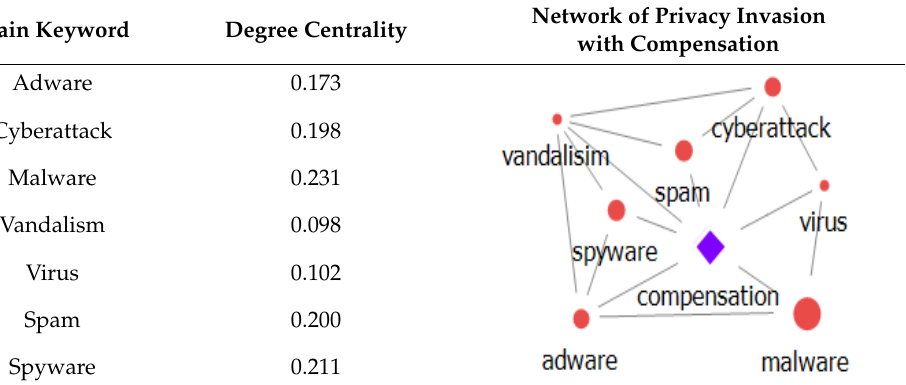
Table 7. Degree Centrality of Compensation.